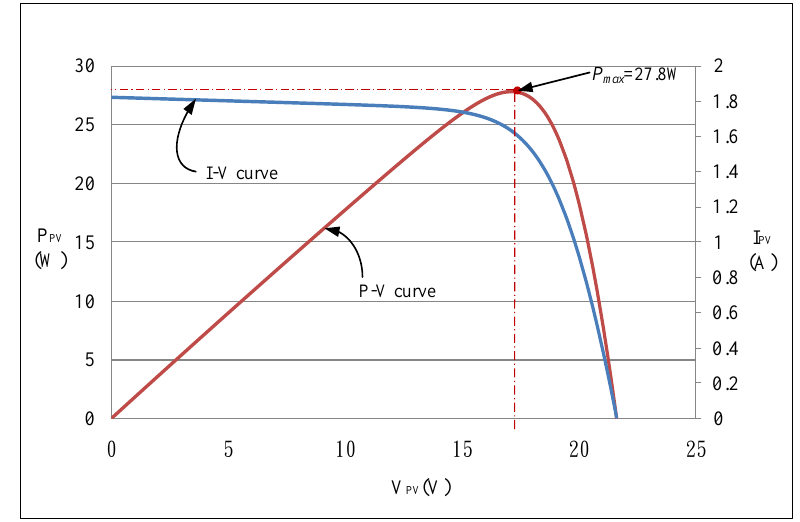
Figure 7. I–V and P–V characteristic curves of one-serial and one-parallel module array with 0% shading.